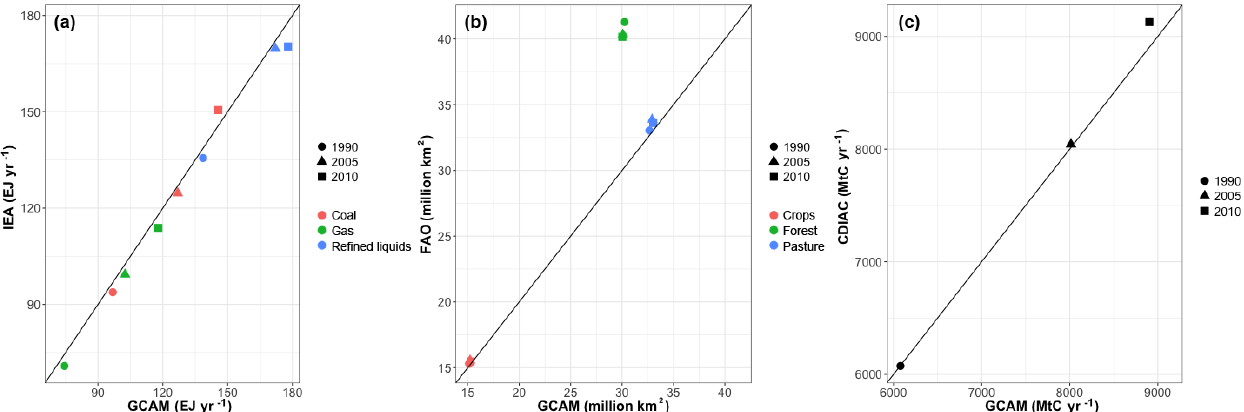
Figure 15. GCAM results versus historical inventory data. Primary energy consumption for fossil fuels, compared to IEA (a) . Global land cover by type, compared to FAO (b) . Global fossil fuel and industrial CO 2 emissions, compared to CDIAC (c) . Data are from the CORE scenario, but all GCAM scenarios are identical in the historical